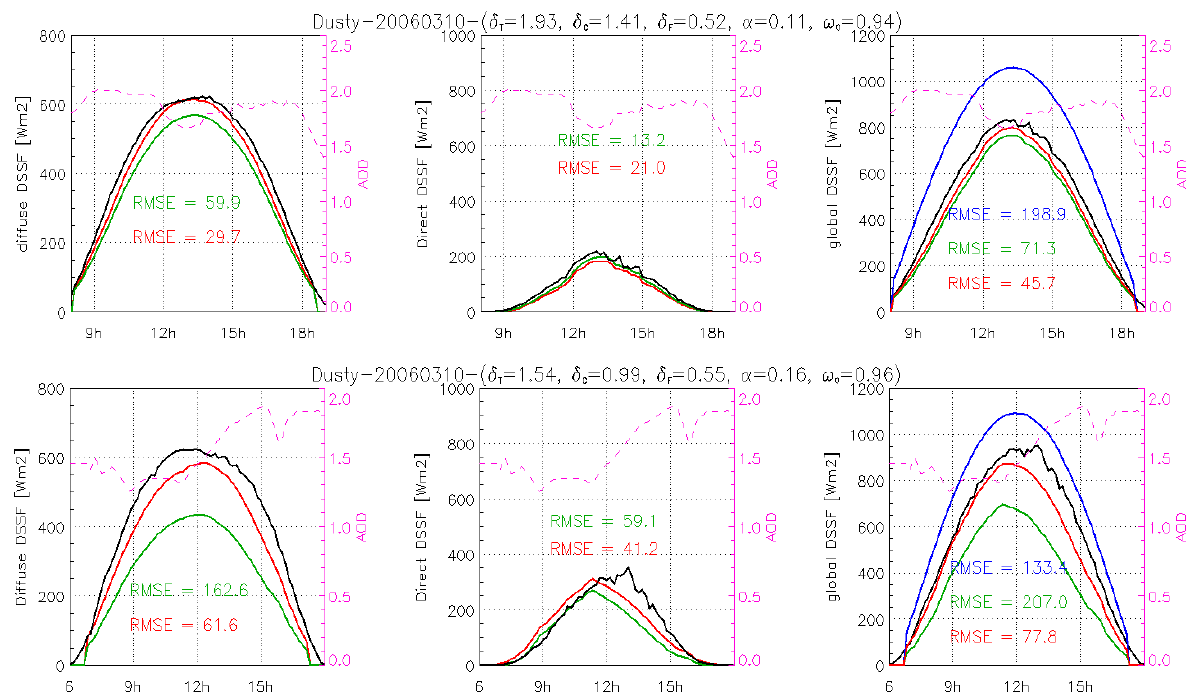
Figure 8. Same as Figure 5 for dusty days in Dakar (10 March) and Niamey (10